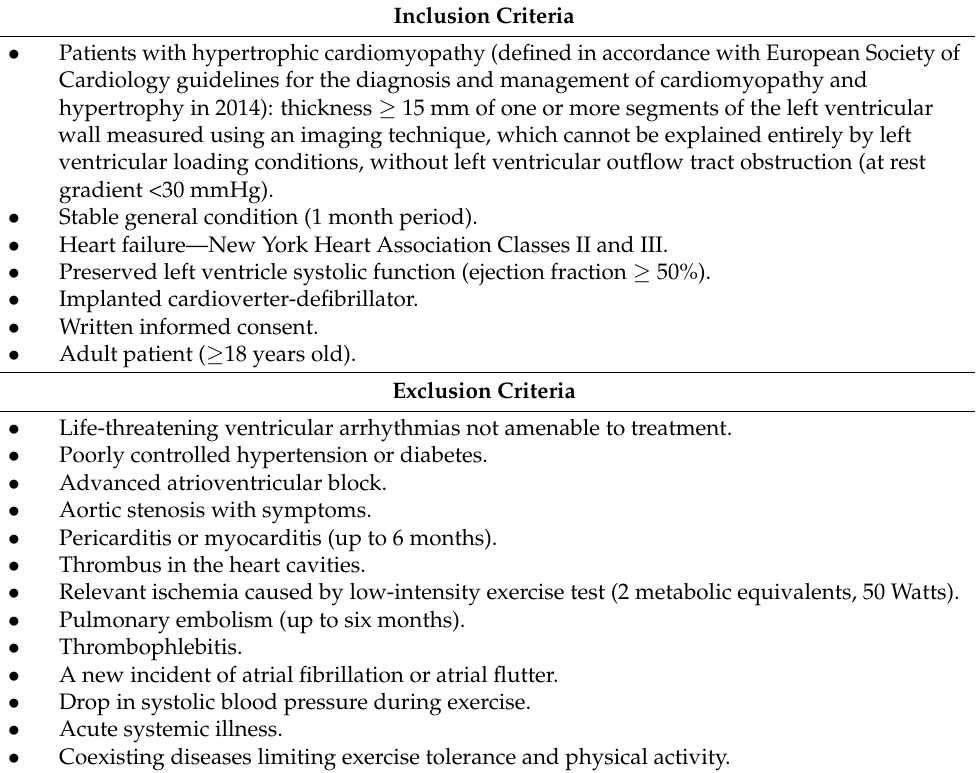
Table 1. Inclusion/exclusion criteria.